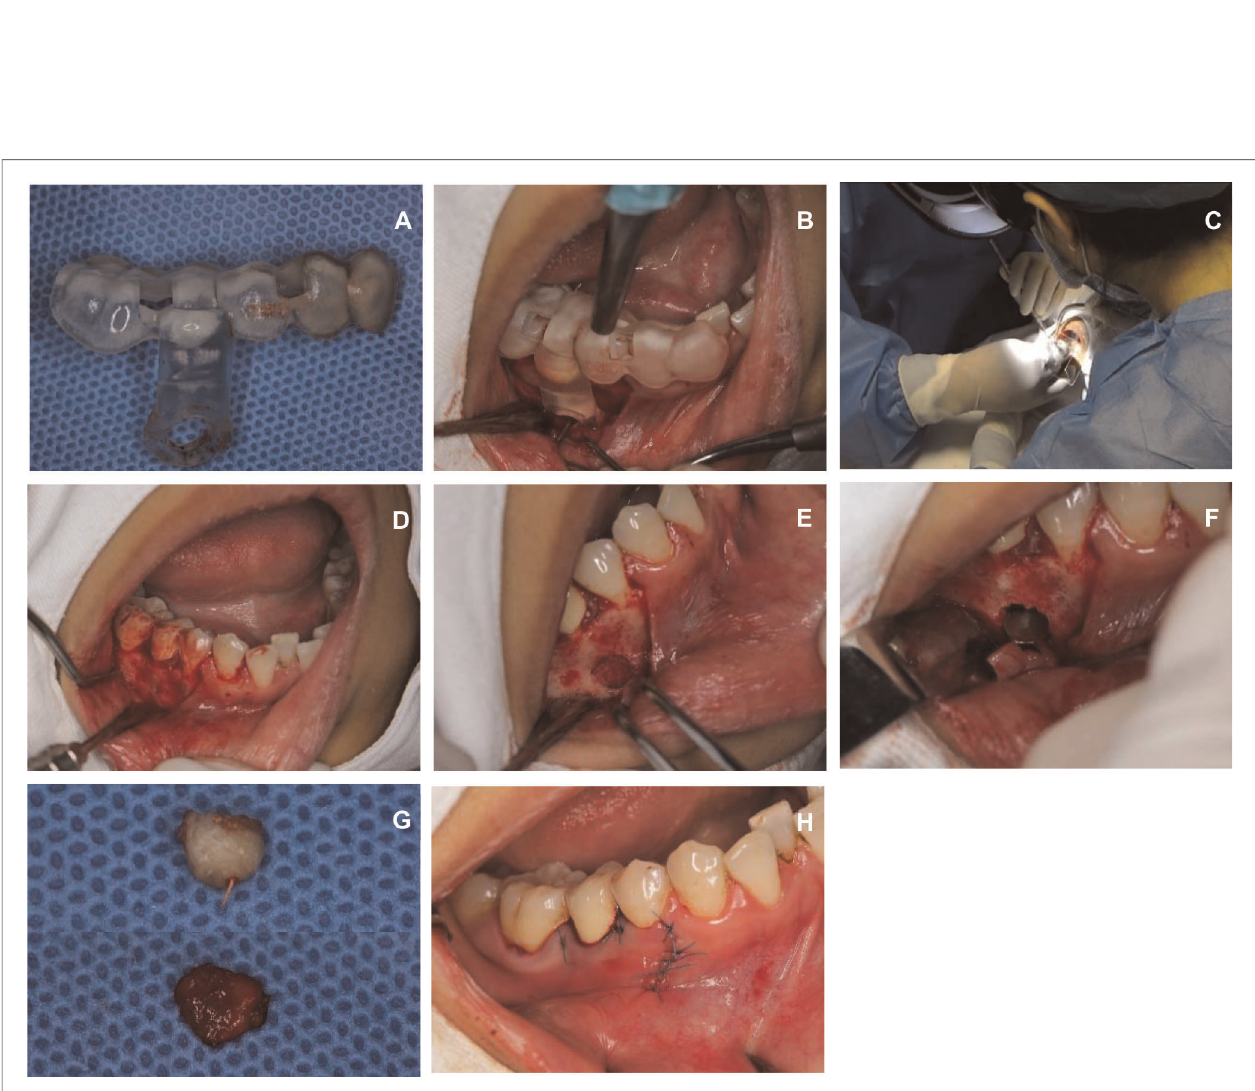
FIGURE 4 | The surgical template and the MR holographic image were combined to position the mandibular opening window. ( A ) Intraoperative surgical template application ( B ) Retaining surgery template ( C ) Projecting MR holographic image into patients ( D ) Precise positioning of the window midpoint ( E ) Opening the window on the bone surface ( F ) Cutting off apical lesions ( G ) Apical lesions were successfully removed ( H ) Tightly sutured mucoperiosteal fl